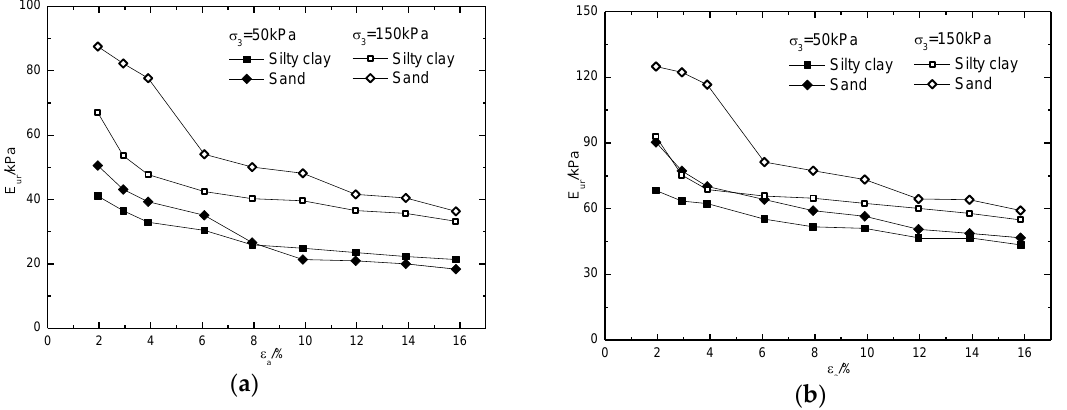
Figure 9. Resilient modulus versus axial total strain under different confining pressures: ( a ) aw = 14%; ( b ) aw =